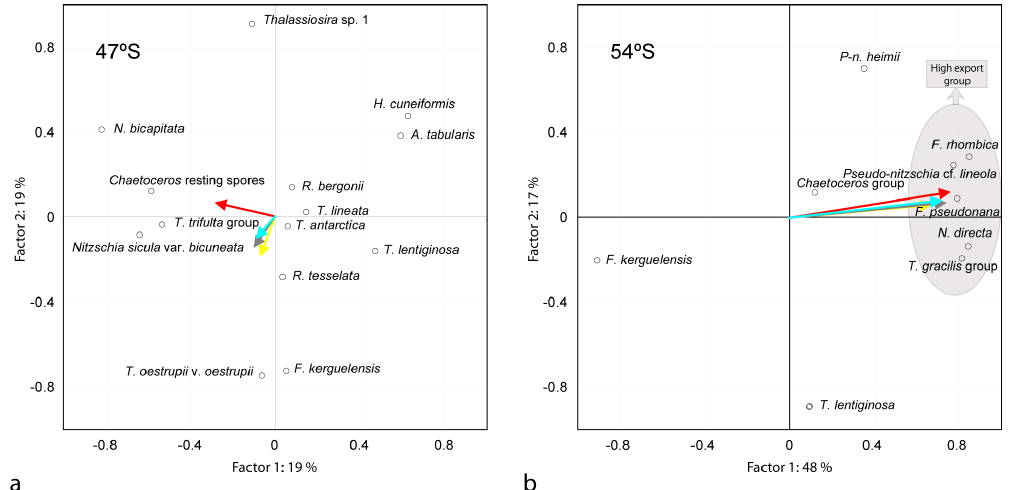
Figure 6. Principal component analysis for the PFZ 47 ◦ S (a) and SAZ 54 ◦ S sites (b) . Projection of the variables (diatom species or groups of species accounting for more than 1% of the integrated assemblage for the whole sampling period) on the first two PCA axes together with total mass (grey), biogenic silica (blue), carbonate (yellow) and POC (red)